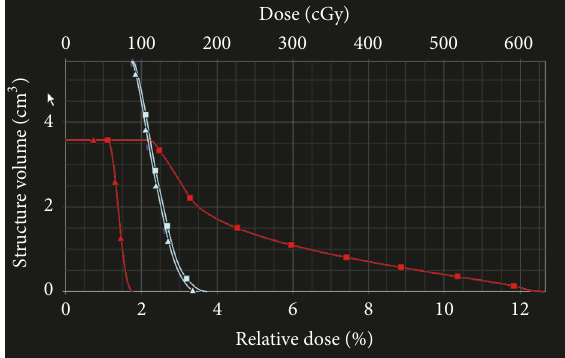
(b) Dosevolumehistogramcomparisonoftheright(blue)andleft(red) ovaryforastandardplan(square)andanovaryavoidanceplan(triangle) for a patient with a right proximal medial thigh soft tissue sarcoma